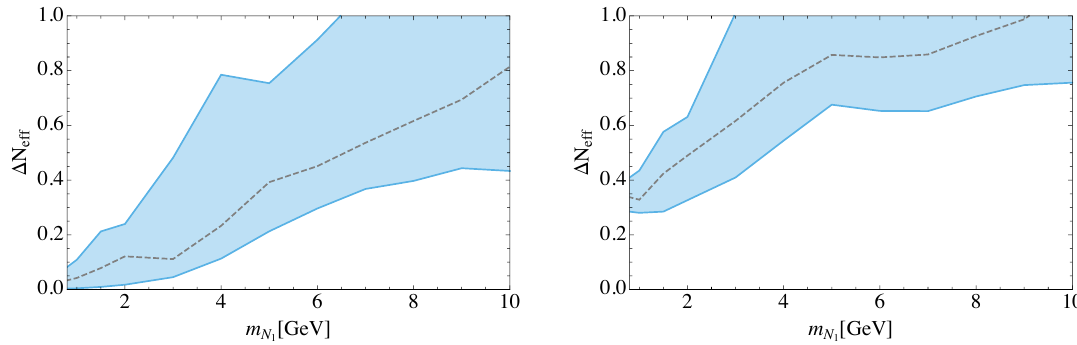
Figure 4 . The range of (cid:1) N e(cid:11) as a function of the lightest right handed neutrino mass which is produced in an ensemble of phenomenologically viable anarchic models (see the text for details). We have taken (cid:15) = 0 and 0.05 in the left and right panels respectively. The dashed line shows the result of a particular model, chosen